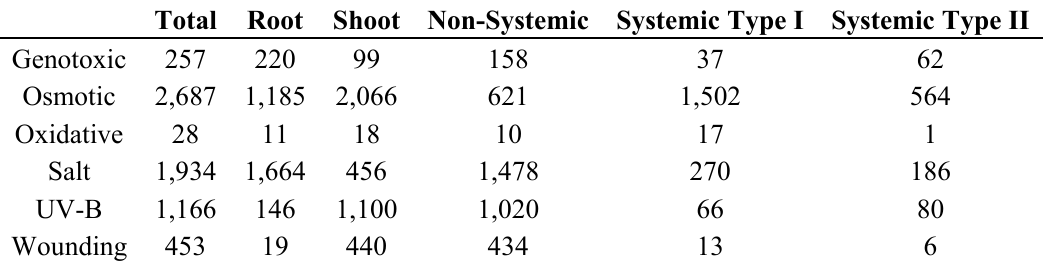
Table 1. Number of genes involved in a systemic or non-systemic stress response. Genes were classified as regulated under high-stringency conditions, as was described in the